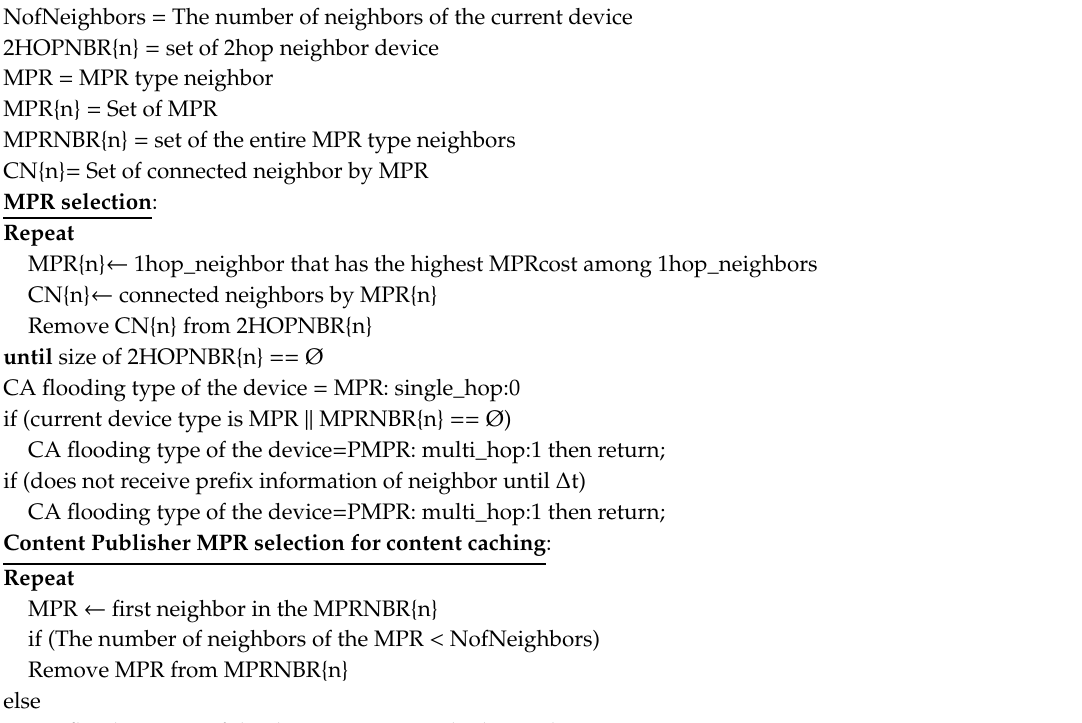
Algorithm 1 MPR and PMPR